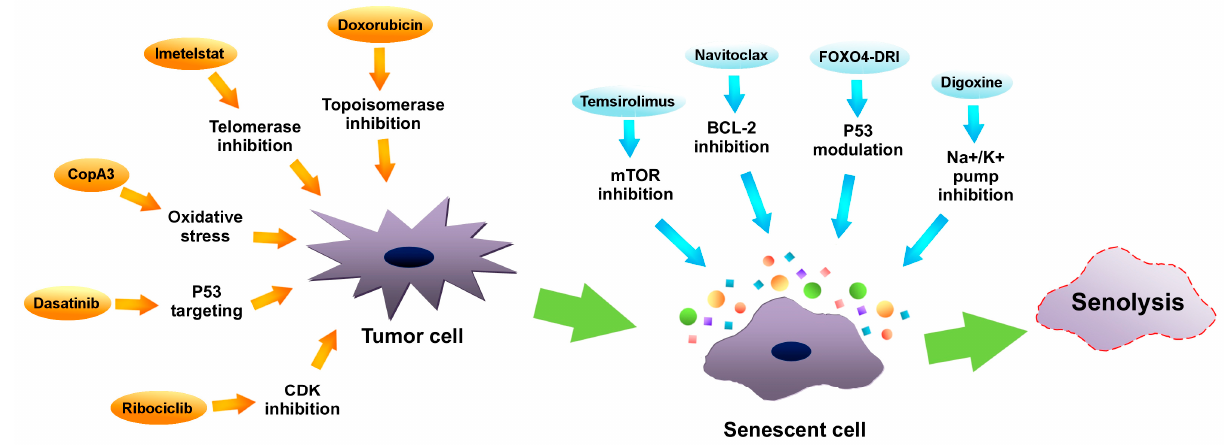
Figure 3. Manipulating senescence in order to eliminate tumor cells by senolysis. Inhibitors of telom- erase (such as imetelstat), inhibitors of topoisomerase (i.e., doxorubicin), cyclin-dependent kinases (CDKs) inhibitors (like ribociclib), oxidative stress inducers (such as CopA3) as well as P53 protein modulators (i.e., dasatinib) (orange arrows) may promote tumor cells senescence. Subsequently, via using mammalian target of rapamycin (mTOR) inhibitors (such as temsirolimus), B-cell lymphoma 2 (BCL-2) inhibitors (like navitoclax), Na + /K + pump inhibitors (such as digoxine) or P53 modulators (like FOXO4-DRI), senolysis of senescent cancer cells can be induced.